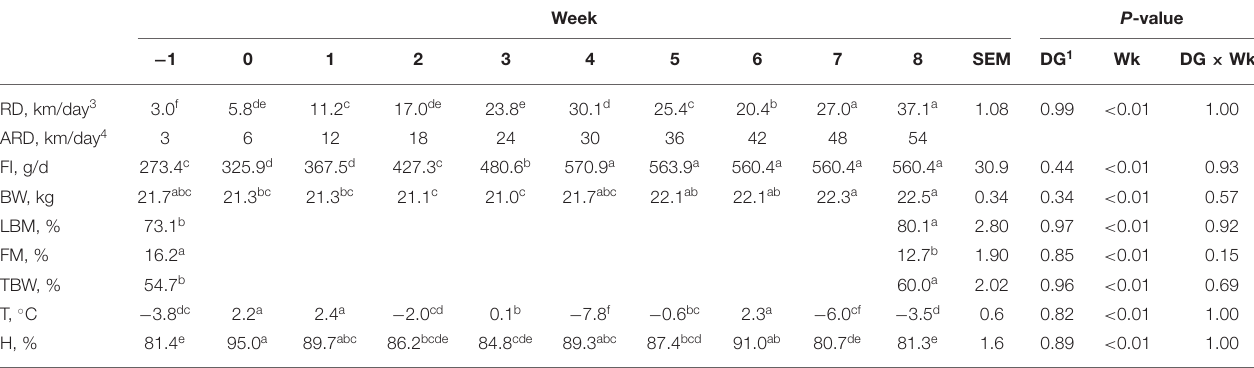
TABLE 2 | Mean daily run distance, feed intake, and BW data for all dogs from weeks − 1 (exercise challenge distance) to 8, body composition data (lean body mass, fat mass, and total body water) at weeks − 1 and week 8, and anticipated run distance for the proposed exercise regimen with mean temperature and humidity for each